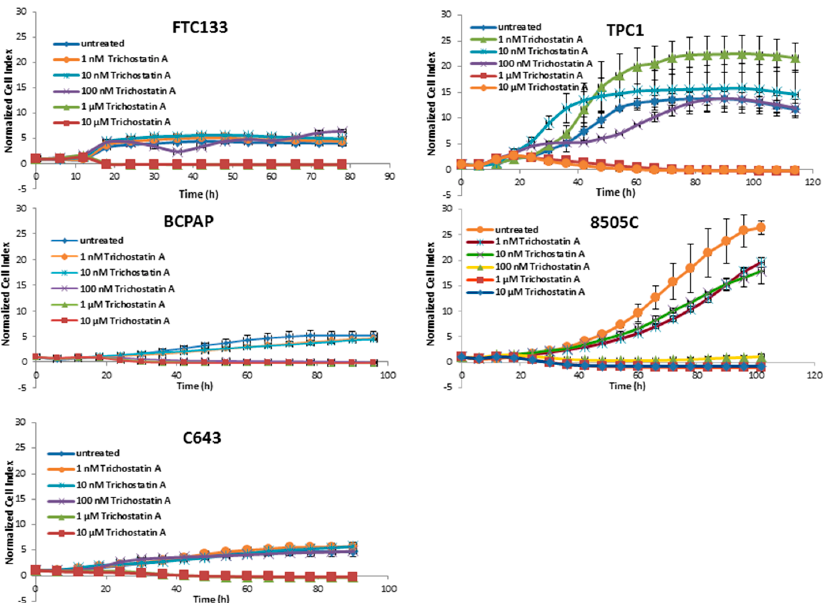
Figure 3. Real time cell viability of thyroid cancer cells treated with Trichostatin A. FTC133, TPC1, BCPAP, 8505C, and C643 cells were plated on gold-coated 96-well plates. After approx. 24 h, Trichostatin A was added at concentration between 1 nM and 10 µM. The cell viability was monitored constantly for up to 100 h. Cell index was normalized to the time point of treatment. Shown are means ± SD of three independent experiments performed in triplicates.